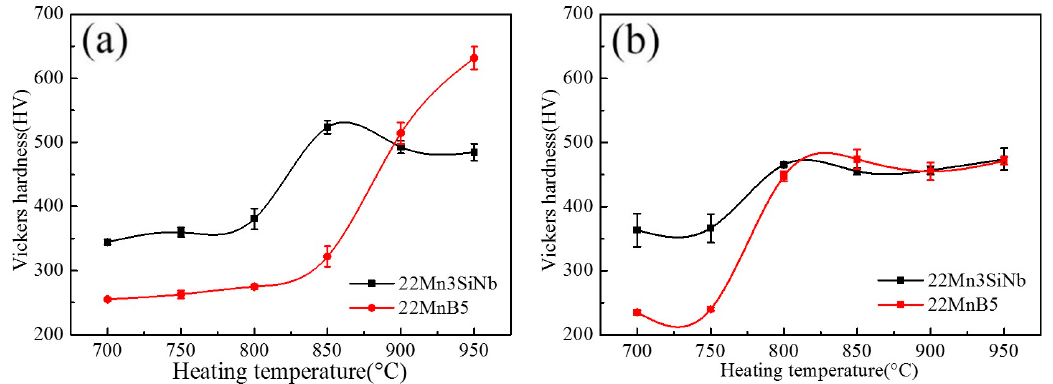
Figure 8. Hardness of two investigated steels after being heated at different soaking times. ( a ) 3 min, ( b ) 5 min.